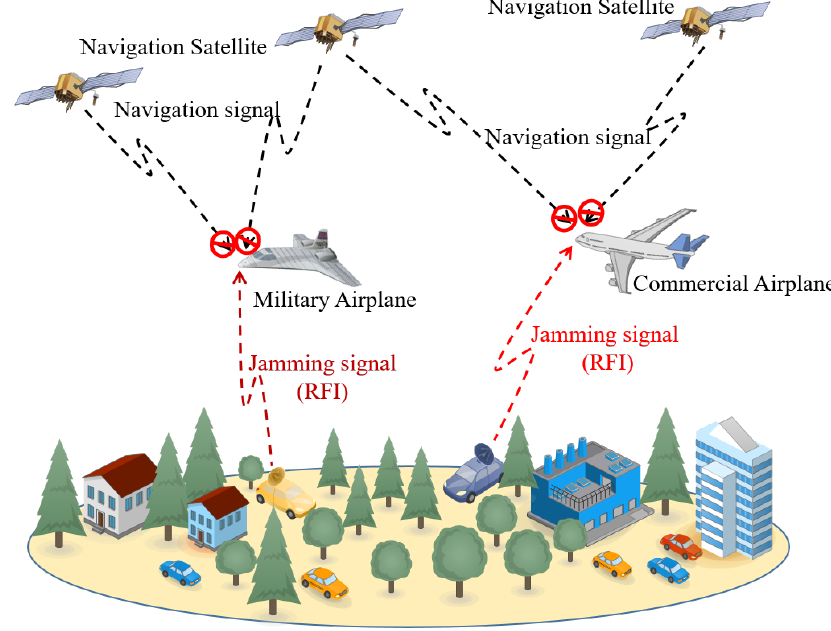
Figure 1. Examples of RFI scenarios that may occur in satellite